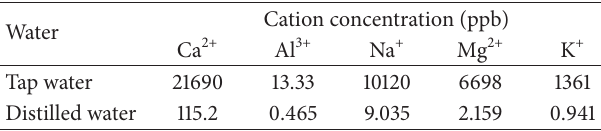
Table 1: Cation compositions of tap water and distilled water.